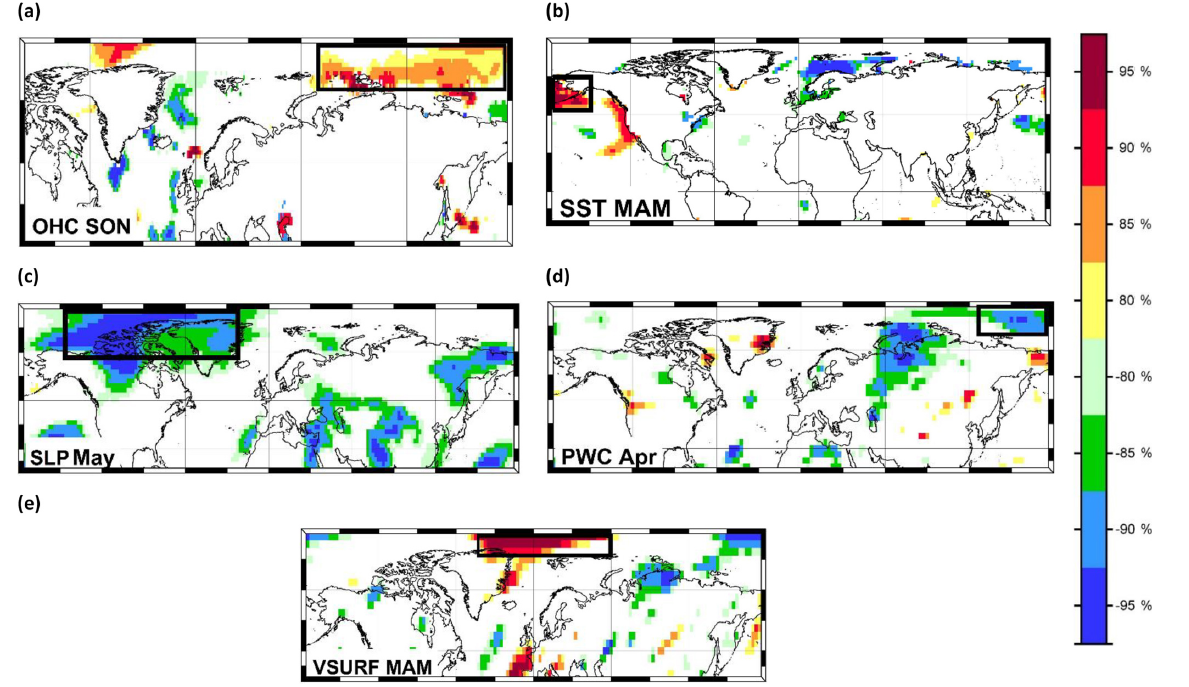
Figure 1. Stability map of the correlation between September sea ice extent and (a) OHC SON, (b) SST MAM, (c) SLP May, (d) PWC Apr and (e) VSURF MAM. Regions where the correlation is stable, positive and significant for at least 80% of the 21-year windows are shaded with dark red (95%), red (90%), orange (85%) and yellow (80%). The corresponding regions where the correlation is stable, but negative, are shaded with dark blue (95%), blue (90%), green (85%) and light green (80%). The black boxes indicate the regions used for the September sea ice extent at the end of